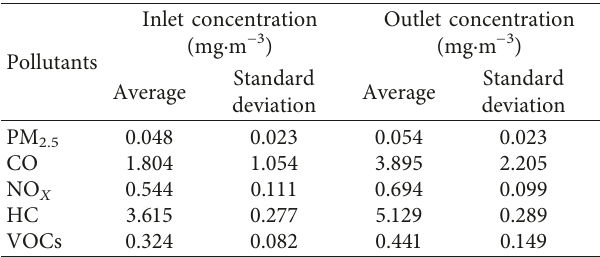
Table 2: Mean mass concentrations of pollutants at the outlet and